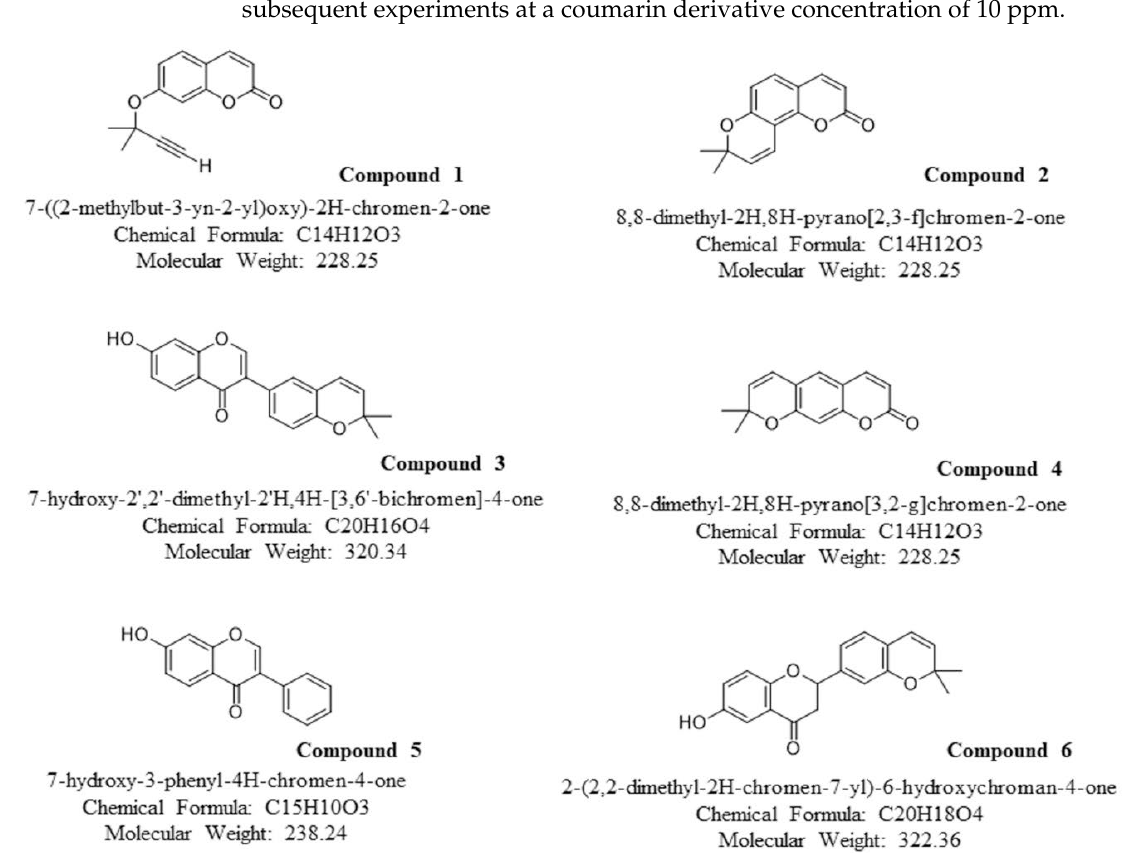
Figure 1. Chemical structure of the different assayed coumarin derivatives.